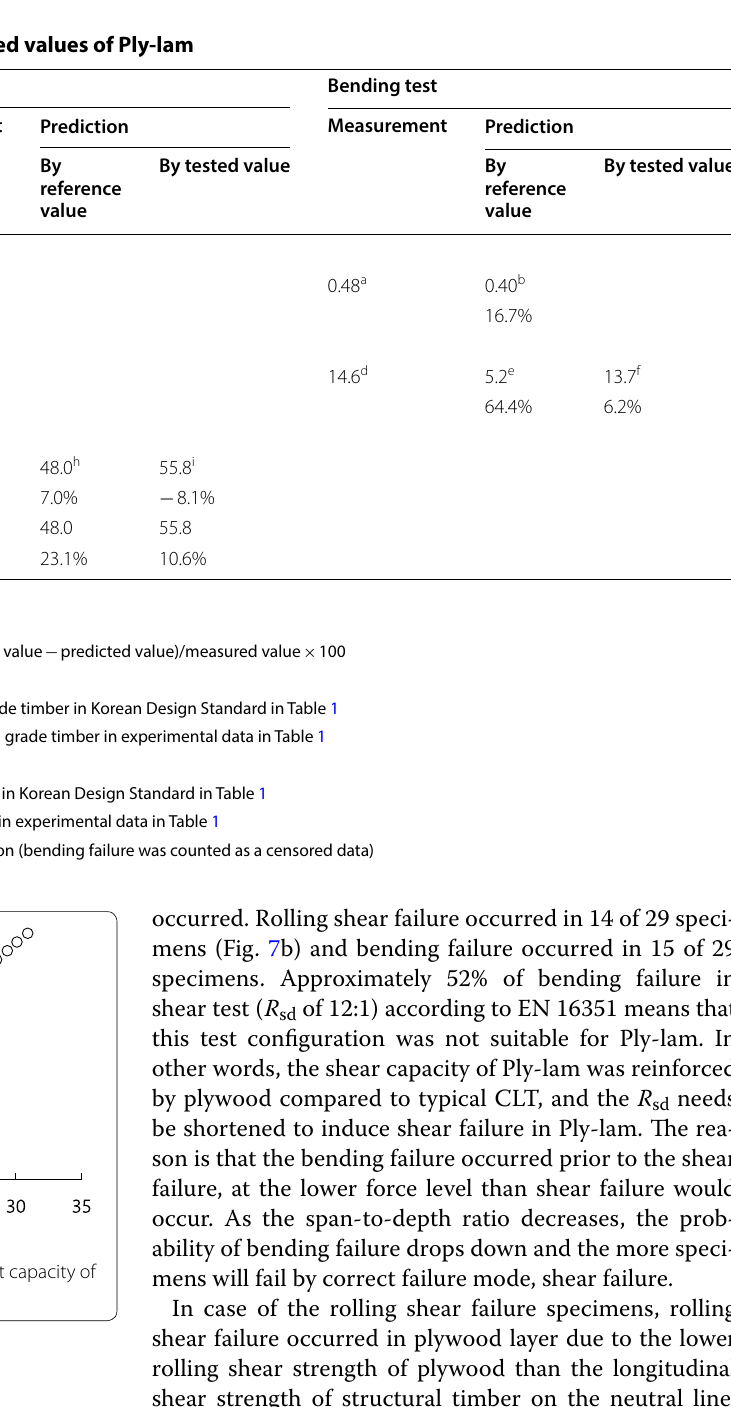
Table 3 Comparisons of measured and predicted values of Ply-lam